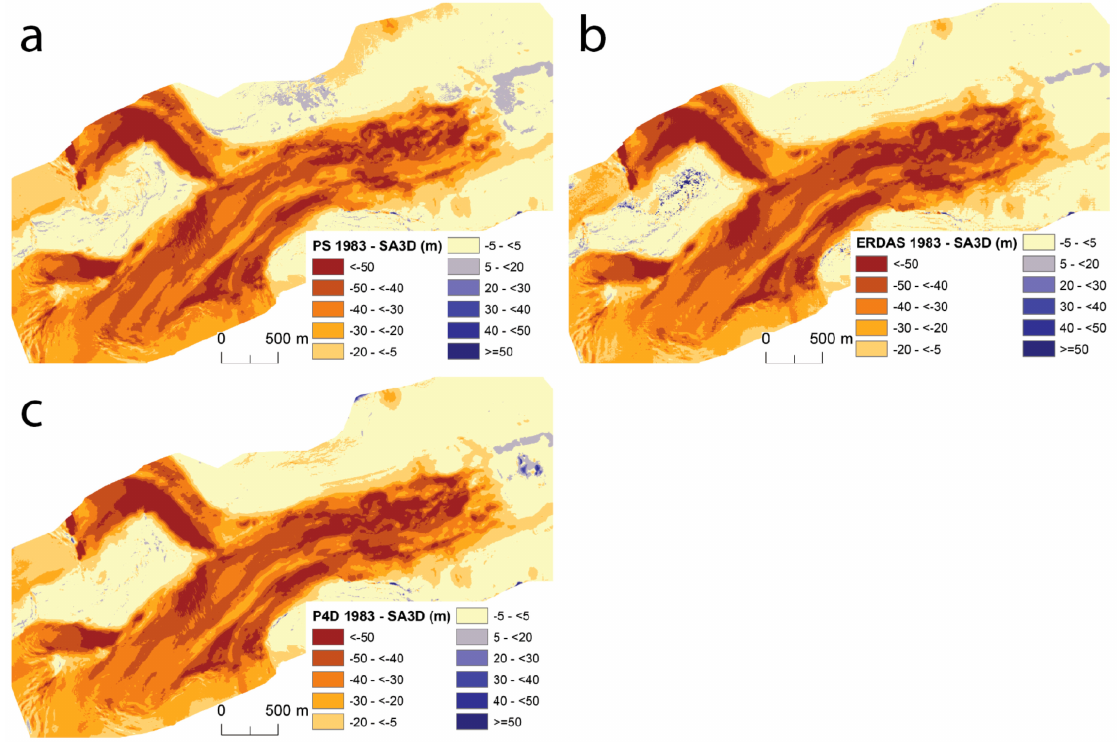
Figure 4. Elevation difference between 1983 and 2012 images for Photoscan ( a ); ERDAS ( b ); Pix4Dmapper ( c ).